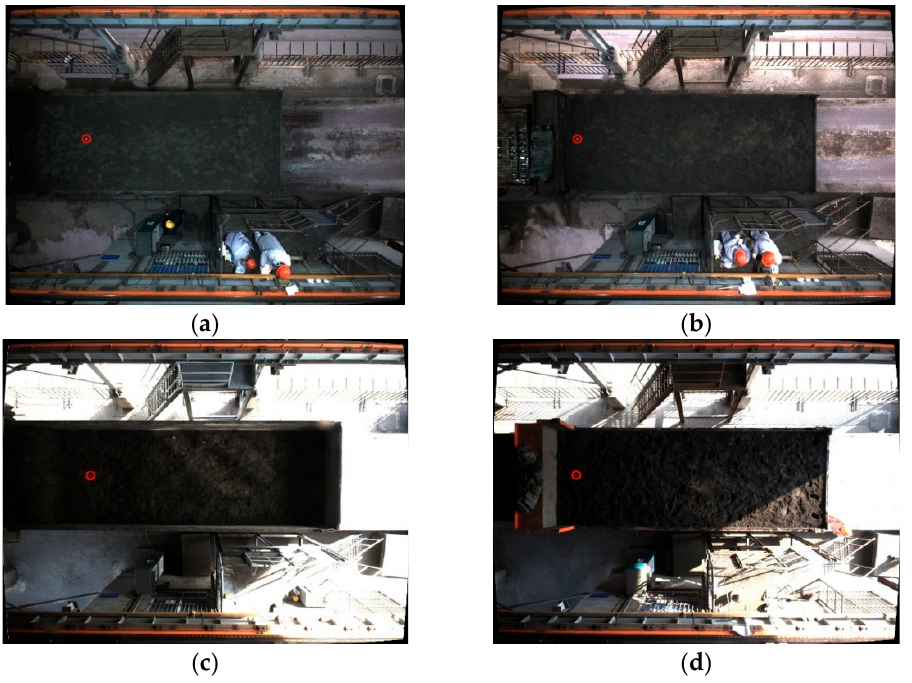
Figure 22. Detection results of green laser spot in different scenes. ( a ) Night scene. ( b ) Rainy day scene . ( c ) Part of the light scene . ( d ) Strong light exposure scenes .